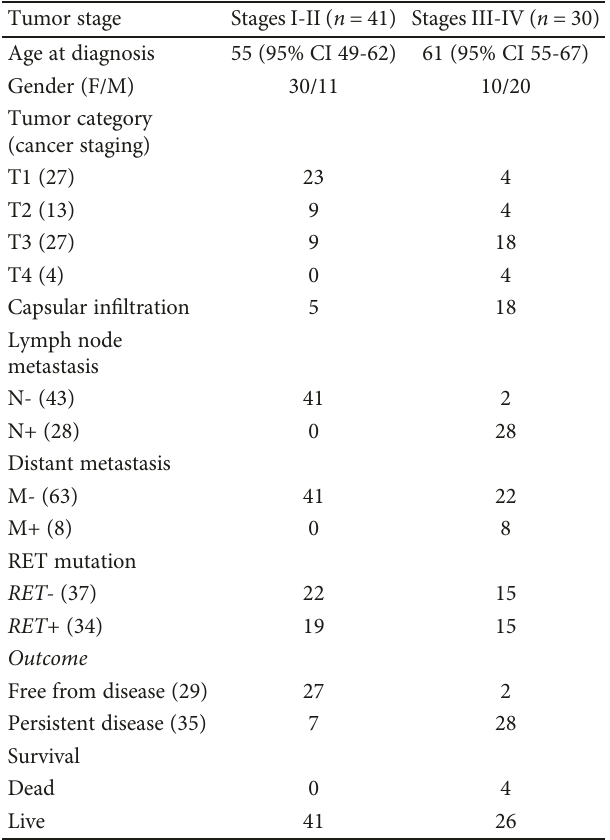
Table 1: Clinical and histological features and follow-up in patients with sporadic MTC in relation to stages I-II and stages